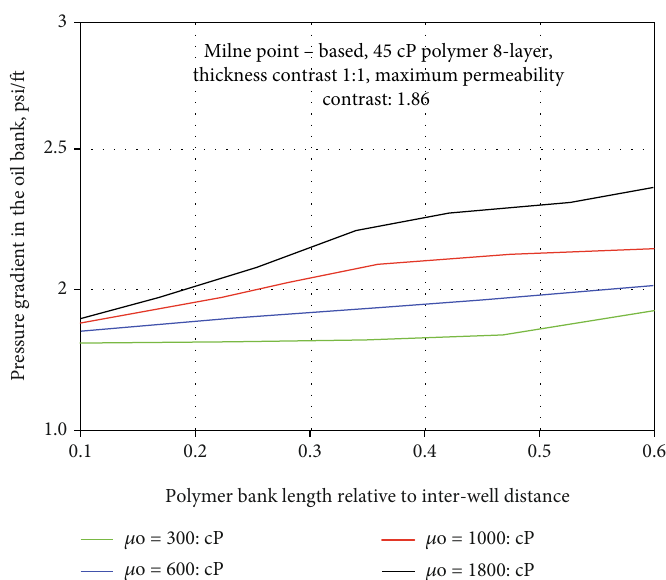
Figure 9: Simulation predicted pressure gradients in the oil bank at Milne Point — based